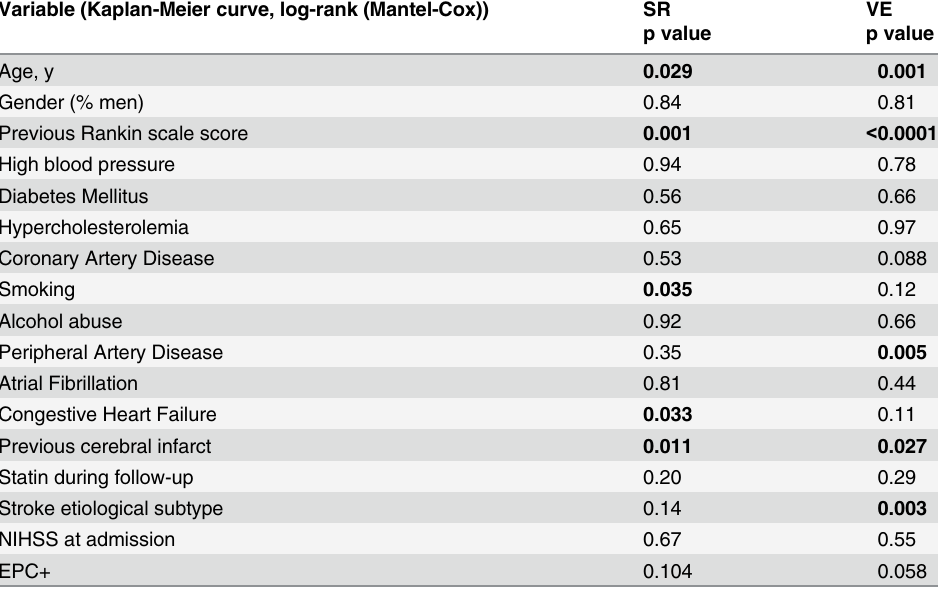
Table 2. Association of Variables in Patients with and Without Stroke Recurrence (SR) or Vascular Event (VE), according to Kaplan-Meier Curves and log-rank Test (Mantel-Cox). Variable (Kaplan-Meier curve, log-rank